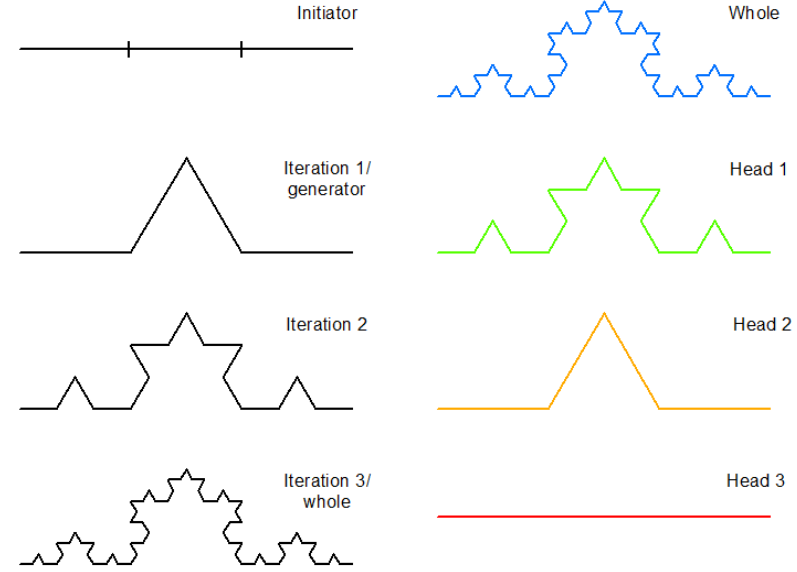
Figure 1. (Color online) Generation and decomposition of the Koch curve. Note: The black curves are seen in a non-recursive view or Euclidean geometric view, while the color curves are in a recursive view or fractal geometric view. For example, the blue curve looks the same as the black curve at iteration 3, but the blue one is seen from the fractal geometric perspective, through which all the subsequent heads shown in color are embedded in the blue one. This recursive or fractal geometric perspective is based on head/tail breaks—a classification scheme and visualization tool for data with a heavy-tailed distribution [19,22].